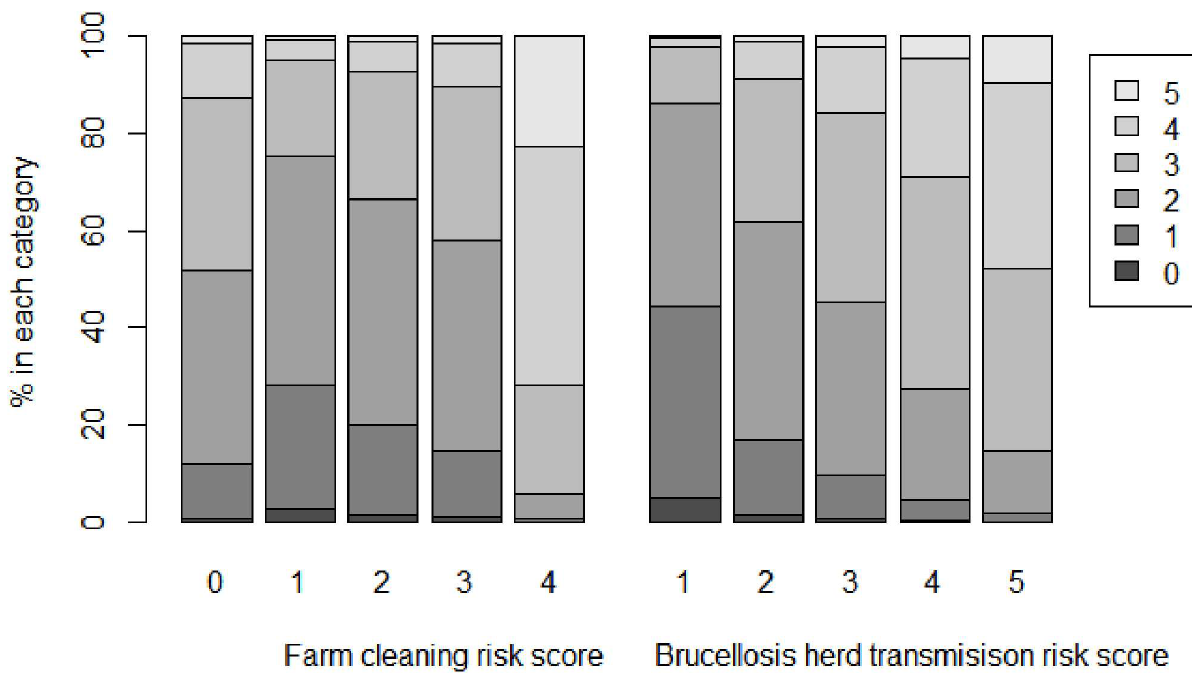
Fig 4. Model-based percentages in each household risk score category (0, 1, 2, 3, 4, 5) across levels of farm cleaning risk scores, and across levels of brucellosis herd transmission risk scores. These values are from the two-variable model and are averagedover the levels of the other factor in the model. Householdrisk scores and brucellosisherd transmission risk scores were calculatedfrom the practices reportedby smallholder dairy farmers who participated in a cross-sectional study on brucellosis in Pakistan